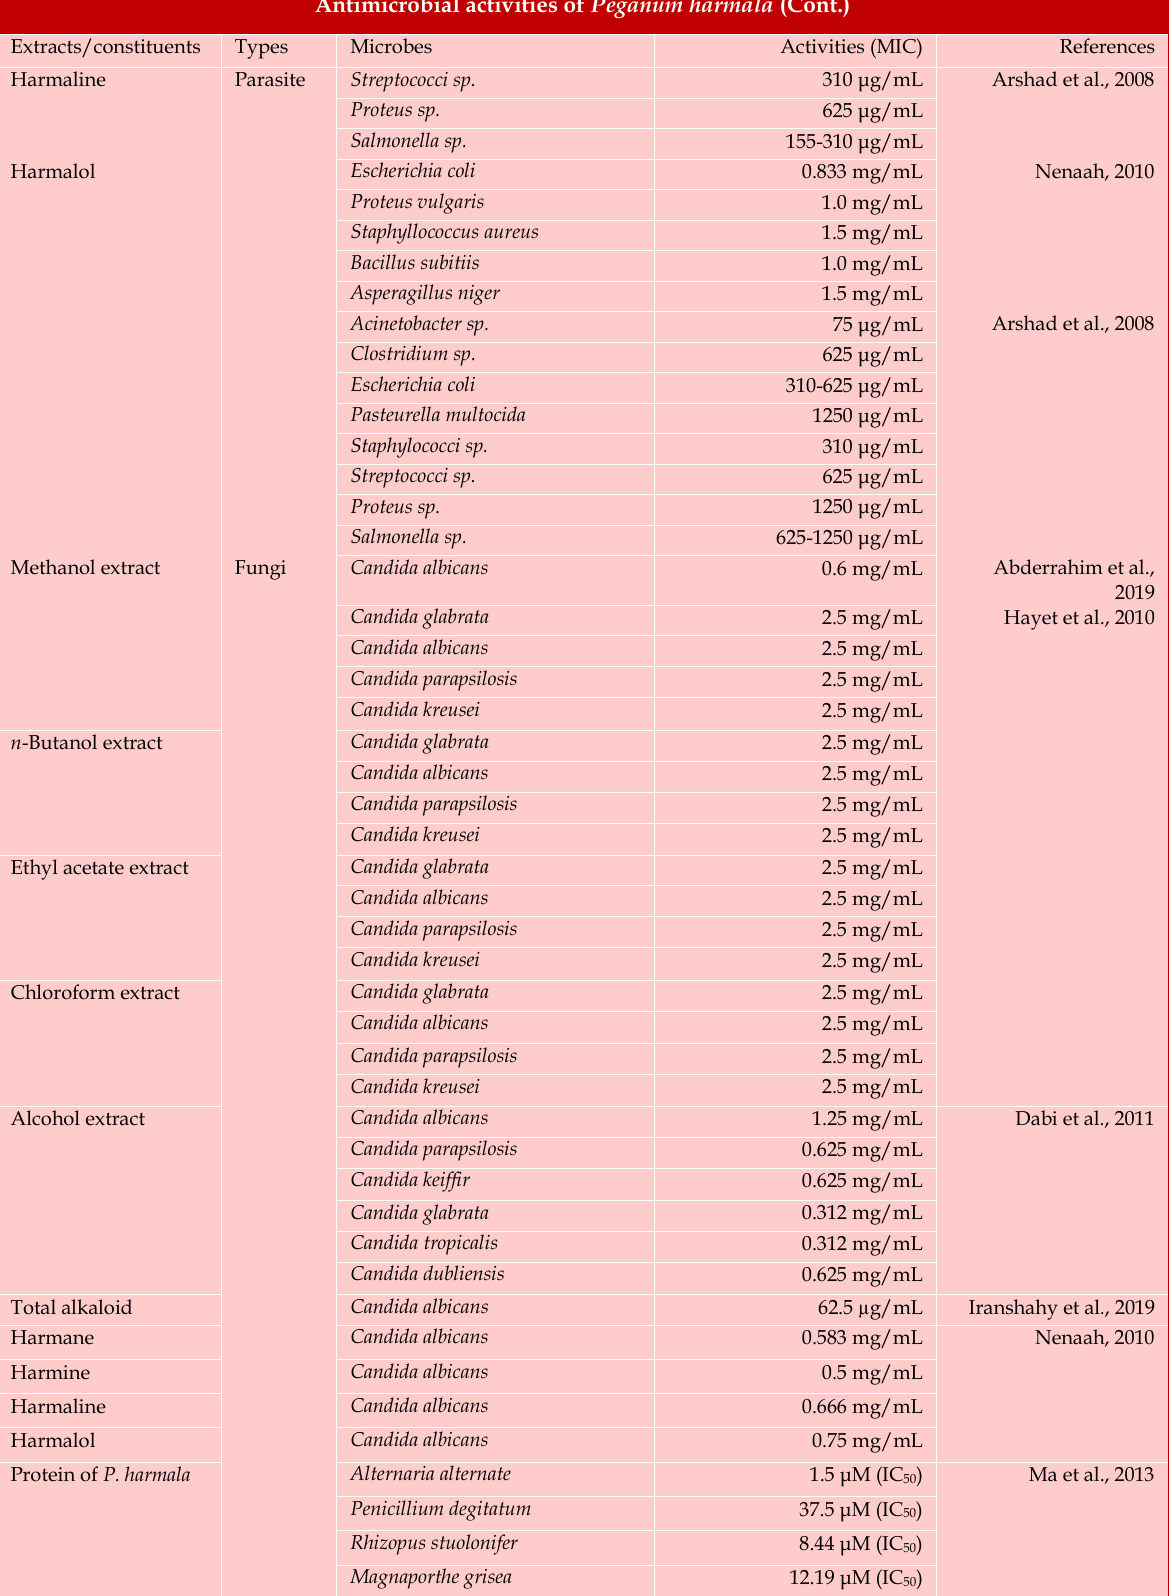
Antimicrobial activities of Peganum harmala